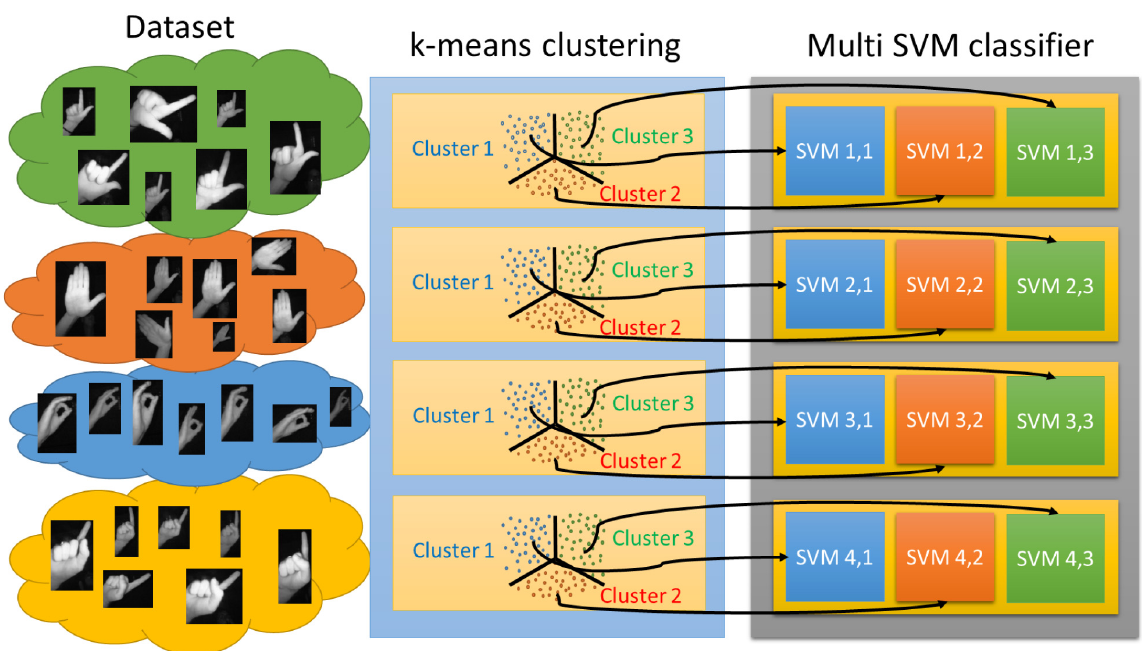
Fig 6. Example of the hand pose classification strategy using four hand poses and three different SVMs per pose, obtained by a k-means strategy.